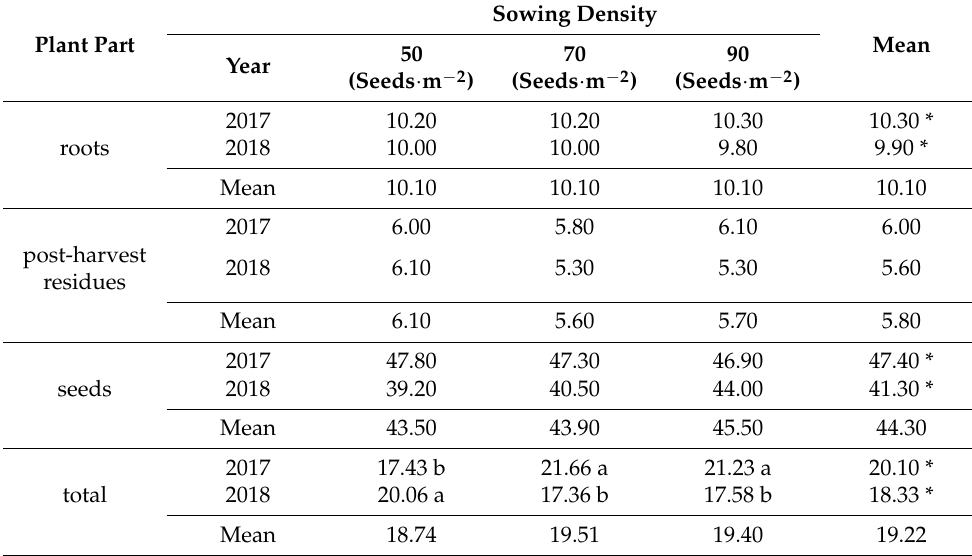
Table 3. Nitrogen content in different soybean parts, g · kg − 1 .